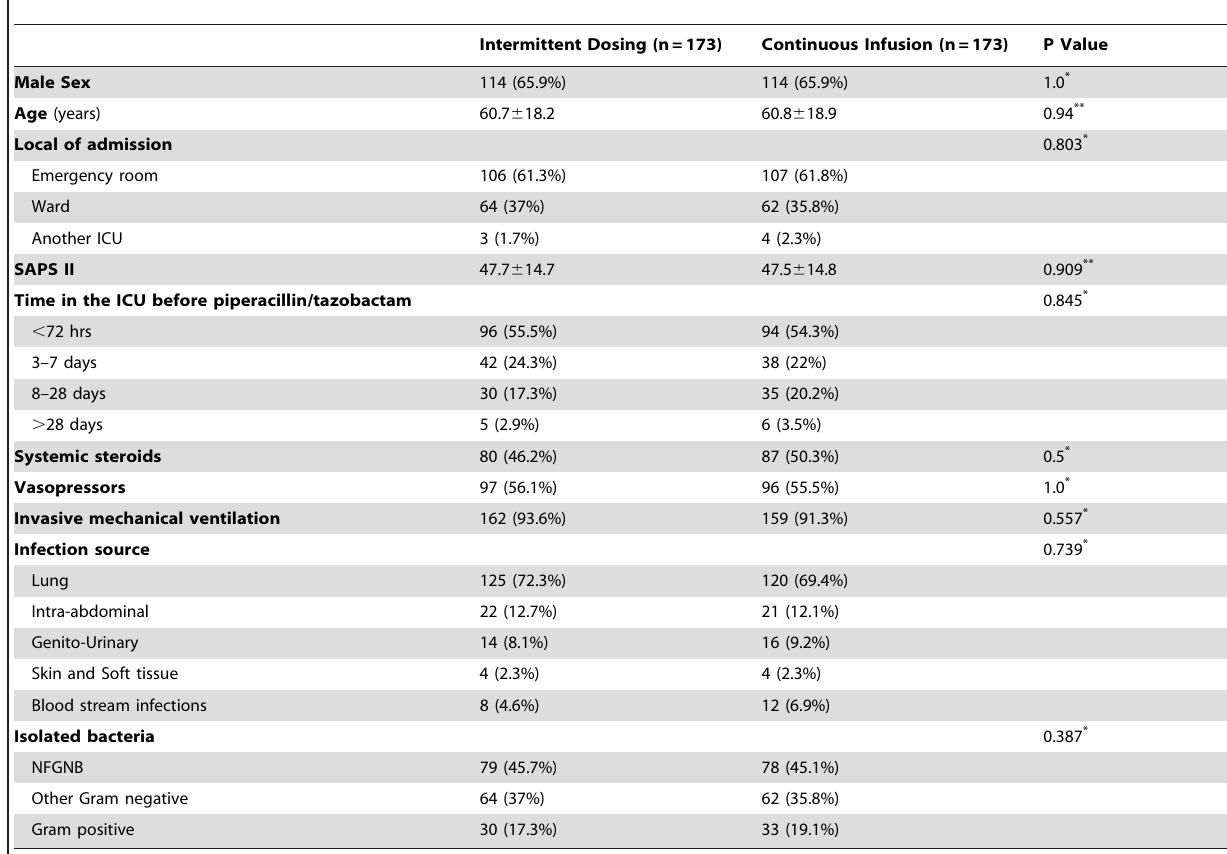
Table 1. Demographic data from the selected matched